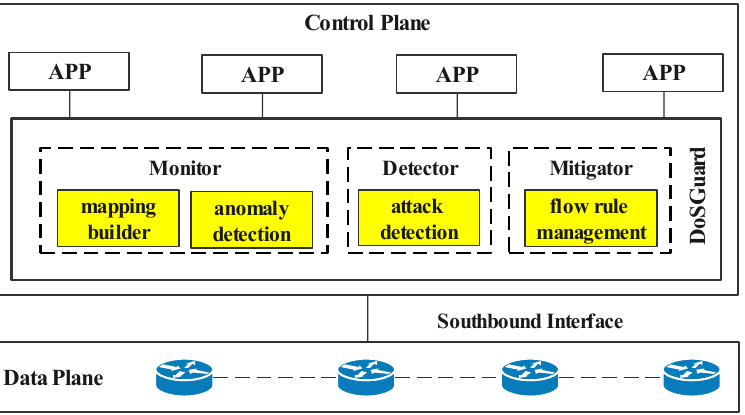
Figure 2. Architecture of DoSGuard.